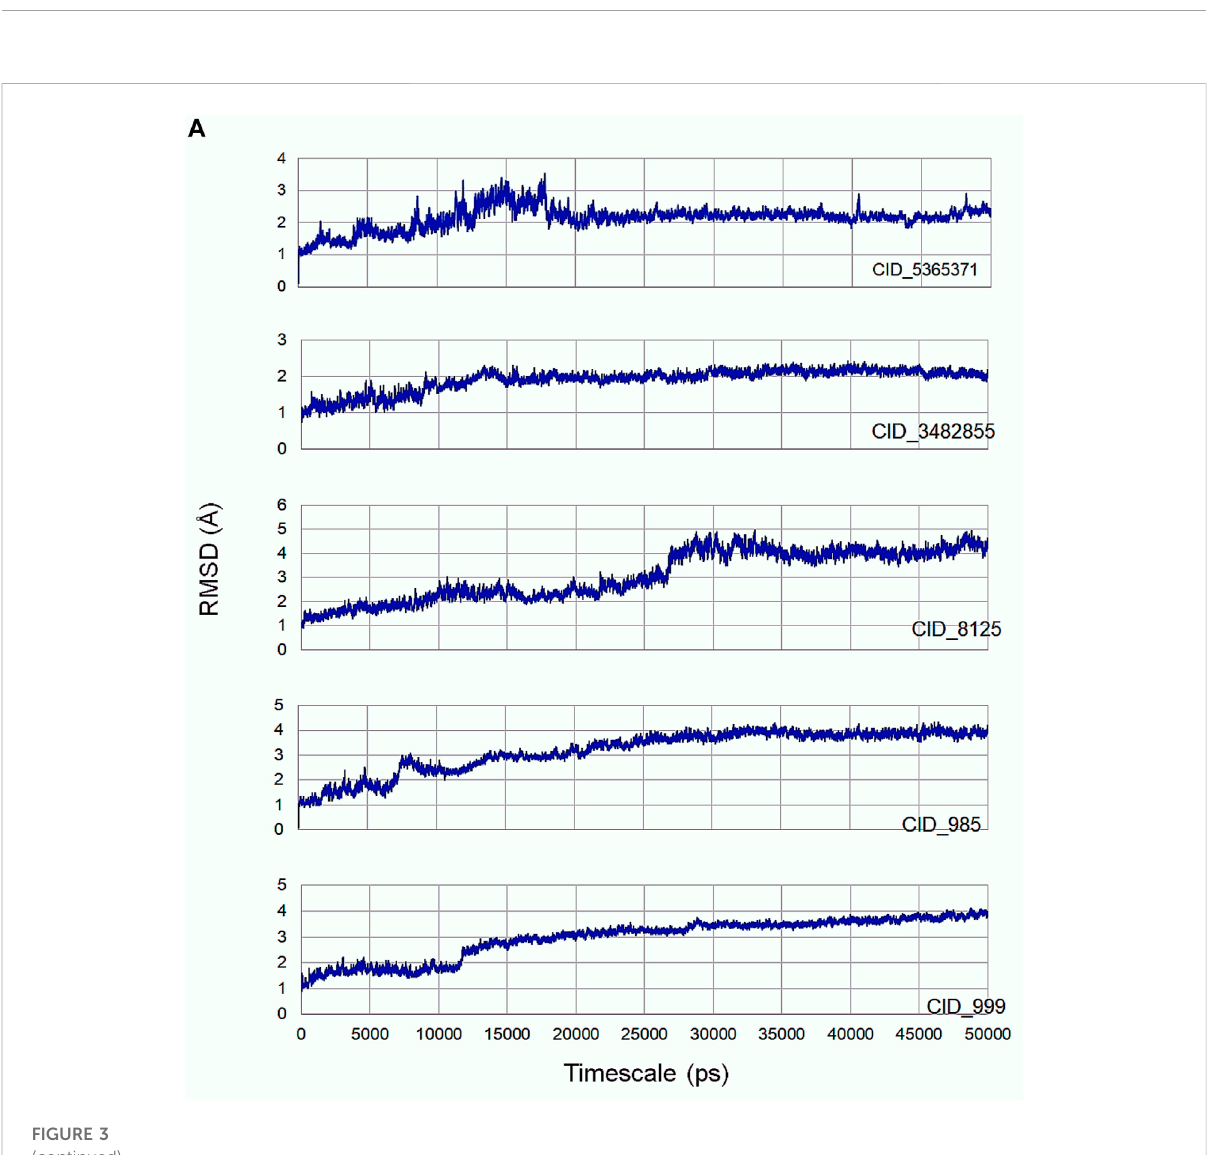
Figure 1. The overall quality factor obtained during ERRAT analysis is 77.5281. In Verify3D, around 80.65% of the amino acid residues have scored ≥ 0.2 in the 3D/1D pro fi le.